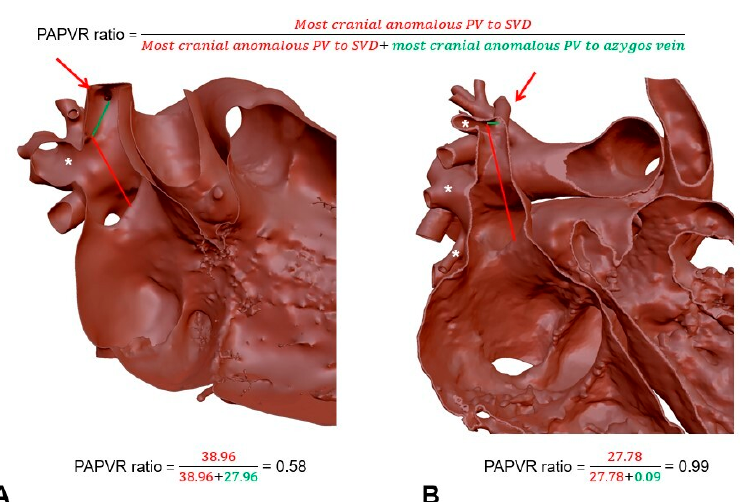
Figure 3. Determination of the PAPVR ratio. ( A ) The calculated formula suggests a double patch repair; and ( B ) the calculated formula suggests a Warden procedure. *: anomalous pulmonary veins; red arrow indicating the azygos